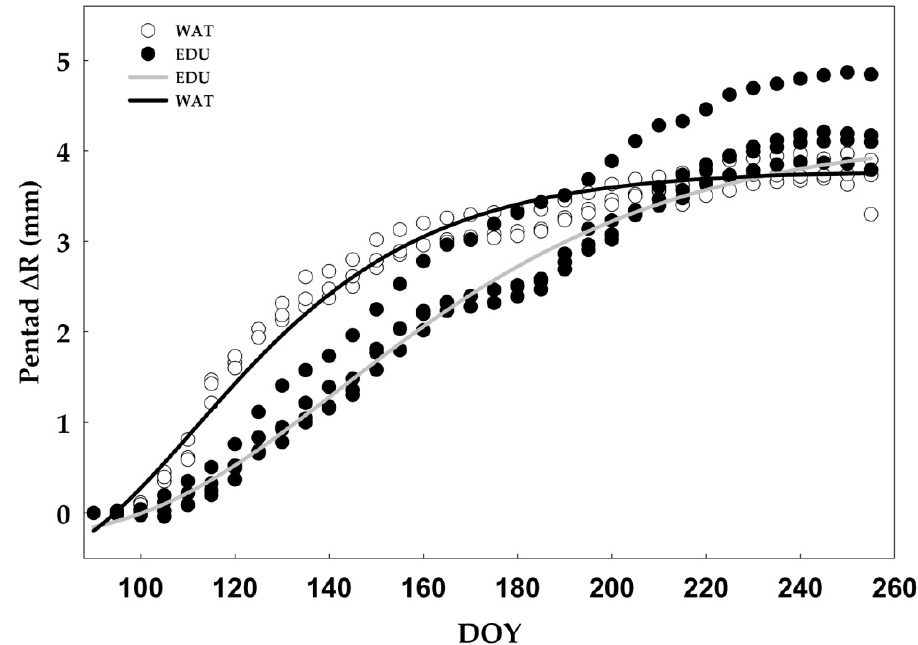
Figure 3. Modelling of the stem radial increase obtained by fitting the Gompertz equation of WAT (water treated, black line) and EDU (EDU treated, gray line) trees. Each point represents the average of maximum values of stem radius over a five-day period ( Δ R pentad) calculated for WAT (white dot) and O 3 -protected EDU trees (black dot). Solid line represents the Gompertz fitting calculated on the mean pentad values of four plants ( N = 5).